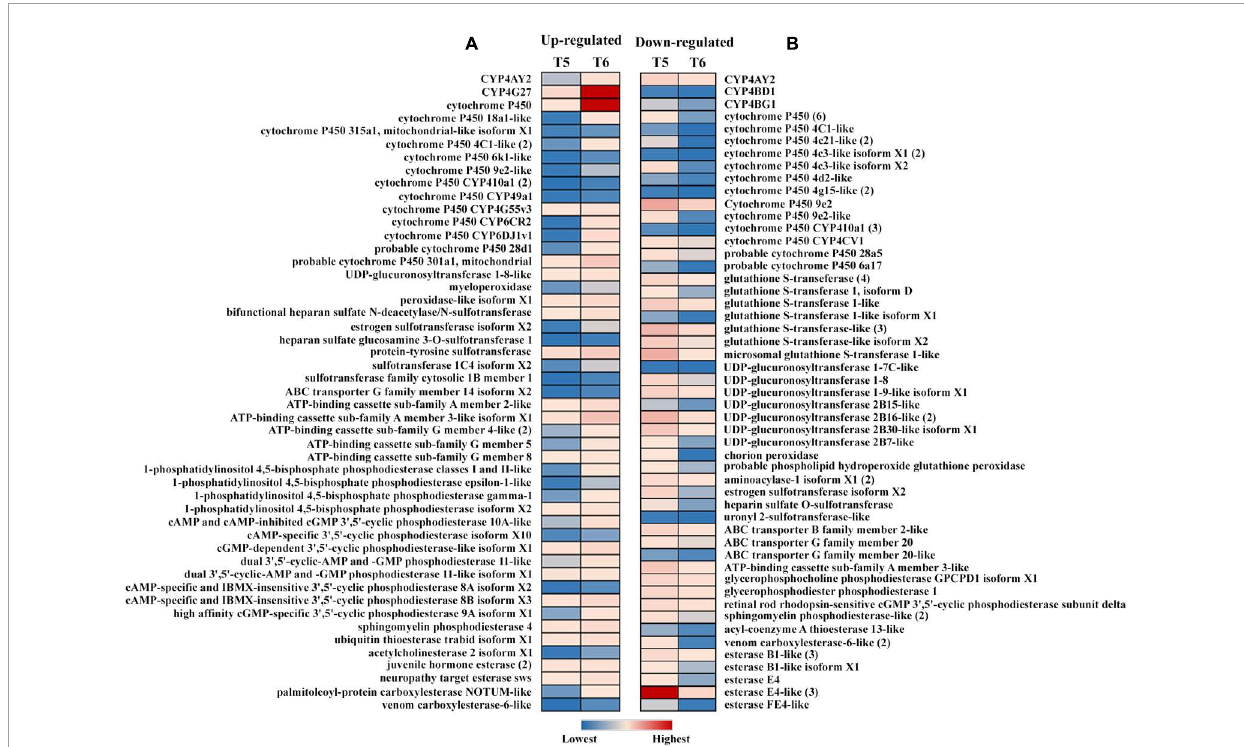
FIGURE9 Expression profiles of detoxification-related genes in the sclerotized male gut (T6) vs. callow male gut (T5) ( N = 5). (A) Upregulated genes FDR corrected p < 0.05 and equal or above the threshold of fold change of 2; (B) downregulated genes FDR corrected p < 0.05 and equal or below the threshold of fold change of –2. The expression level is represented in different colors indicating the TMM-adjusted log CPM expression mean